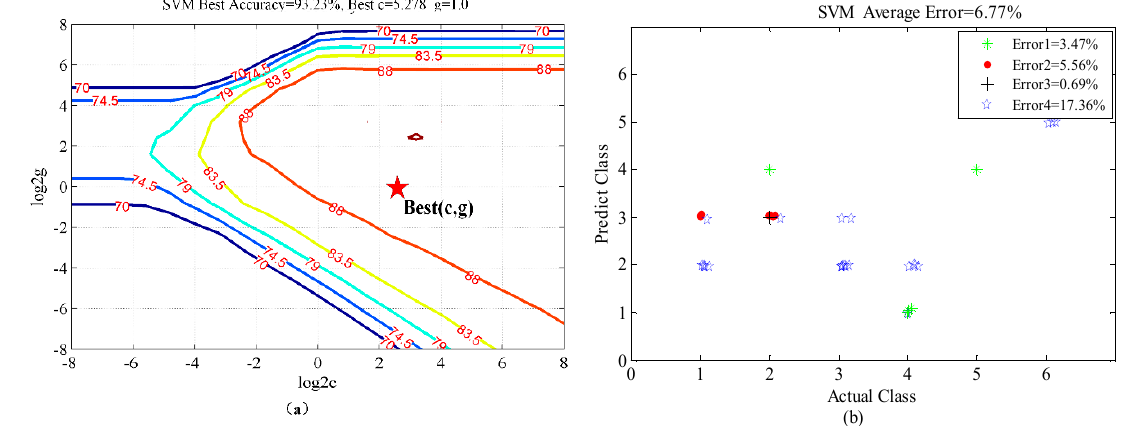
Figure 11. Classification results from four-fold cross-validation for the second scenario ( a ): The parameter selection results. ( b ) Classification errors distribution of the four-fold cross-validation.